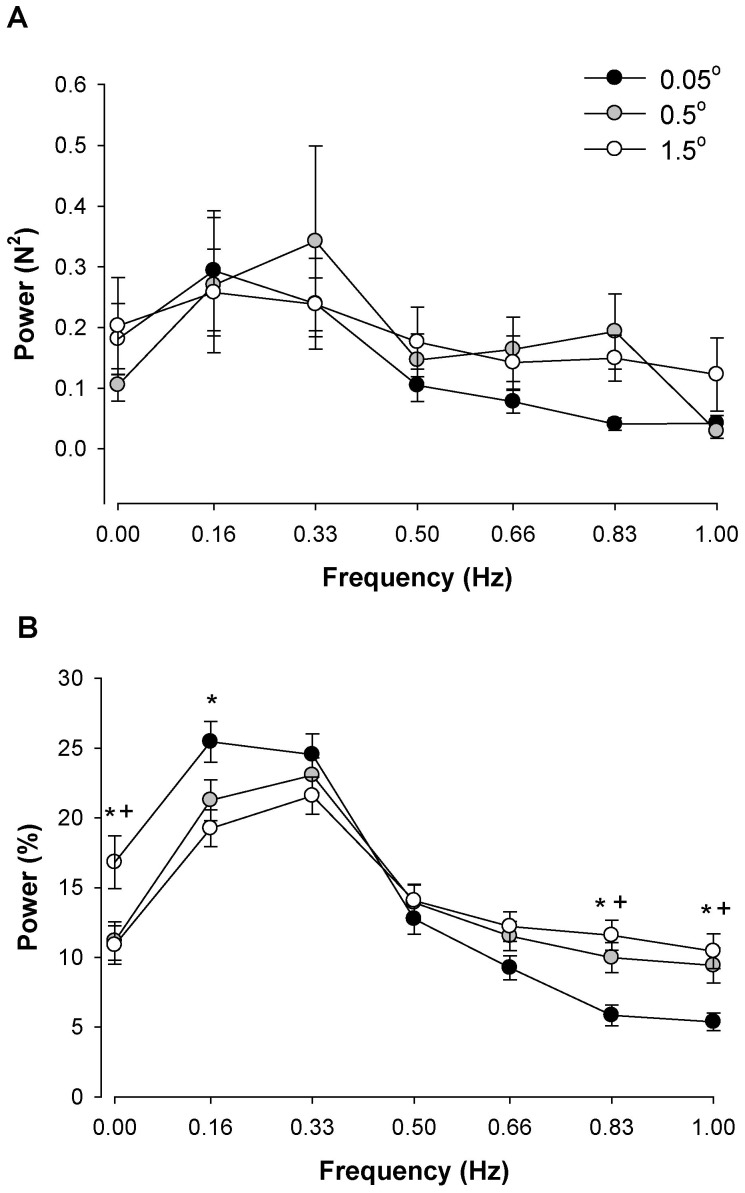
The effect of visual angle and frequency bins below 1 Hz.A: The absolute power as a function of frequency bins during the three different visual angles. The age and visual angle main effects and associated interactions were not significant. B: The normalized power during the two visual feedback conditions. Magnification of visual feedback at the highest visual angle (1.5°) compared with the lowest visual angle (0.05°) significantly decreased force oscillations from 0–0.16 Hz and increased power from 0.83–1.0 Hz. Visual feedback at a moderate visual angle (0.5°) compared with the lowest visual angle (0.05°) increased power at 0 Hz and decreased power from 0.83–1.0 Hz. Asterisk (*) indicates significant difference (P<0.05) between the highest (1.5°) and lowest (0.05°) visual angle. A cross (+) indicates significant difference (P<0.05) between the moderate (0.5°) and lowest (0.05°) visual angle.